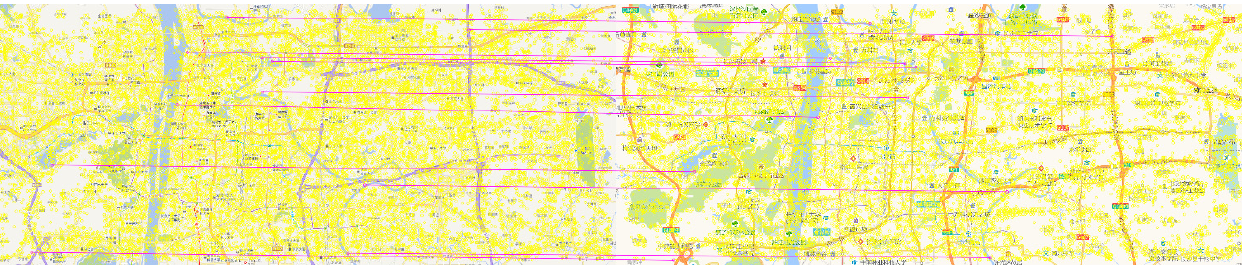
Figure 4. Results after matching and fi ltering in the urban area vector map .